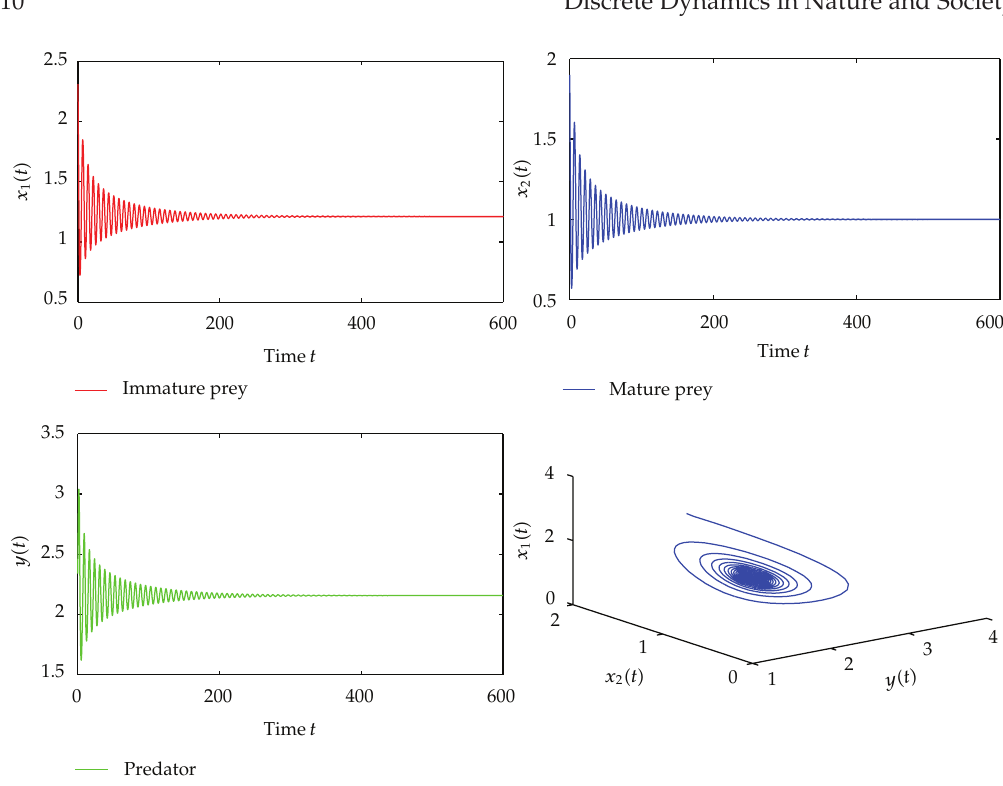
Figure 3: E 0 is locally asymptotically stable for τ 2 (cid:6) 0 . 4400 < τ 20 (cid:6) 0 . 5124 with initial value “2.31; 1.9;